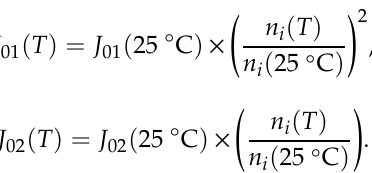
Figure 4. Temperature coefficient of ( a ) V oc and ( b ) fill factor.